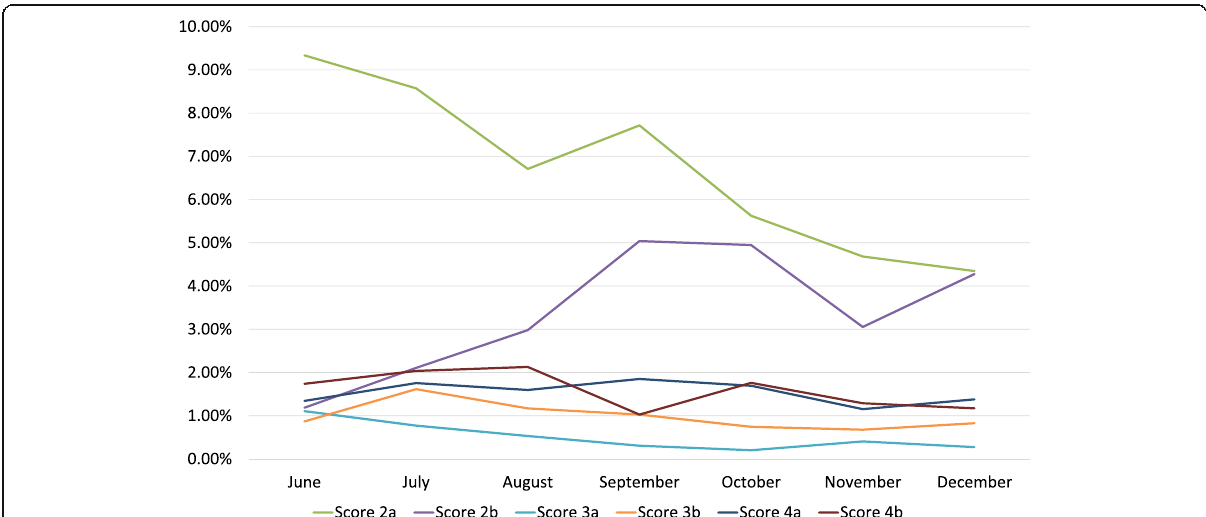
Fig. 5 Evolution of indicators over time in the whole group of residents. Discr/total is the total of discrepancies over the total of preliminary reports (excluding score 0), and b/total is the total of likely to be clinically significant discrepancies (scores 2b, 3b, 4b) over the total of preliminary reports (also excluding score 0)